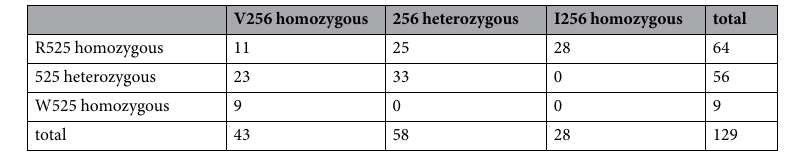
Table 2. Linkage of the TOP1MT 256 and 525 alleles. * Source. 129 samples from women with breast cancers were used to genotype TOP1MT variants for both alleles at positions 256 (V or/and I) and 525 (R or/and W). Chi-square p value =